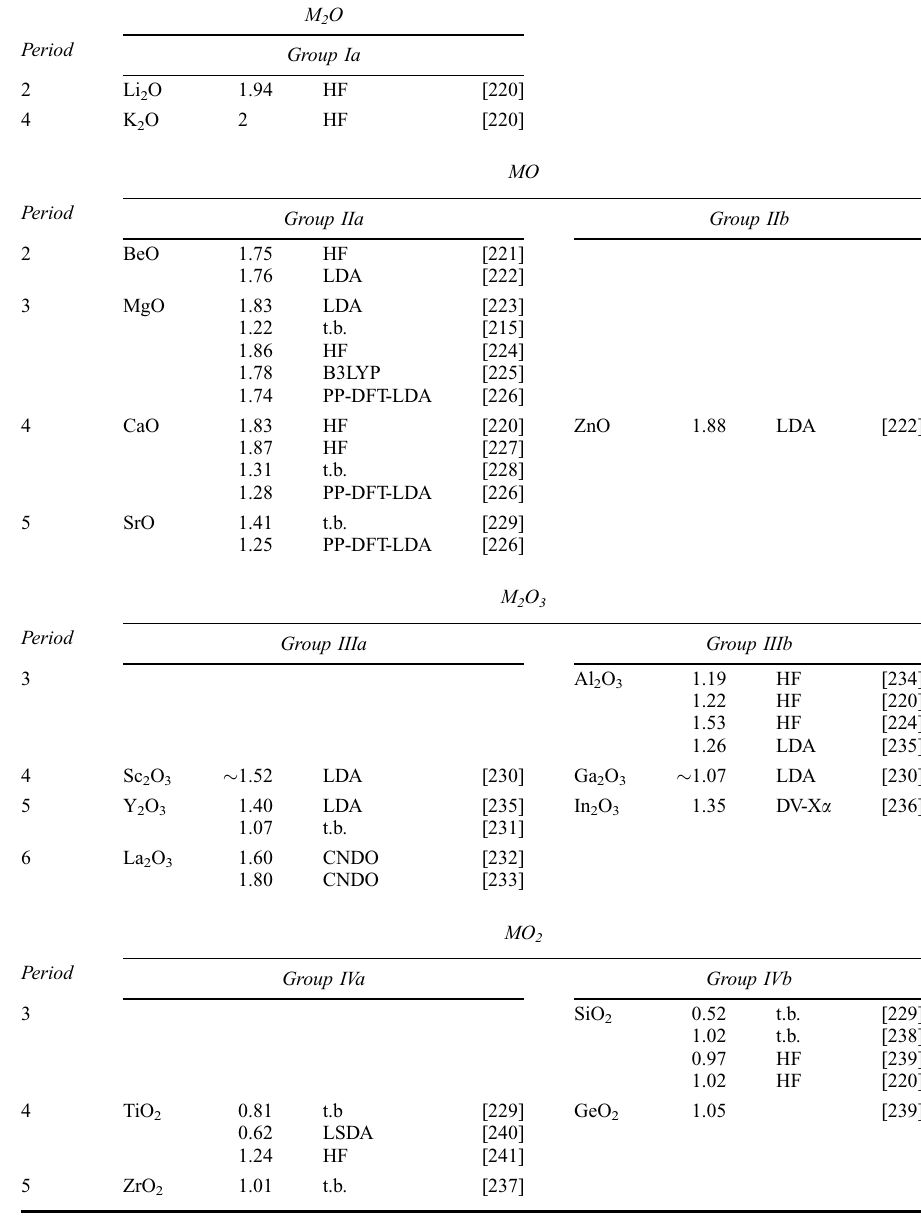
TABLE IX Net Oxygen Charges ( (cid:1) Q Ox ) for Binary Oxides from Various Sources (Electronic Configurations of the Cations: s – p , d 0 and d 10 ). M 2 O